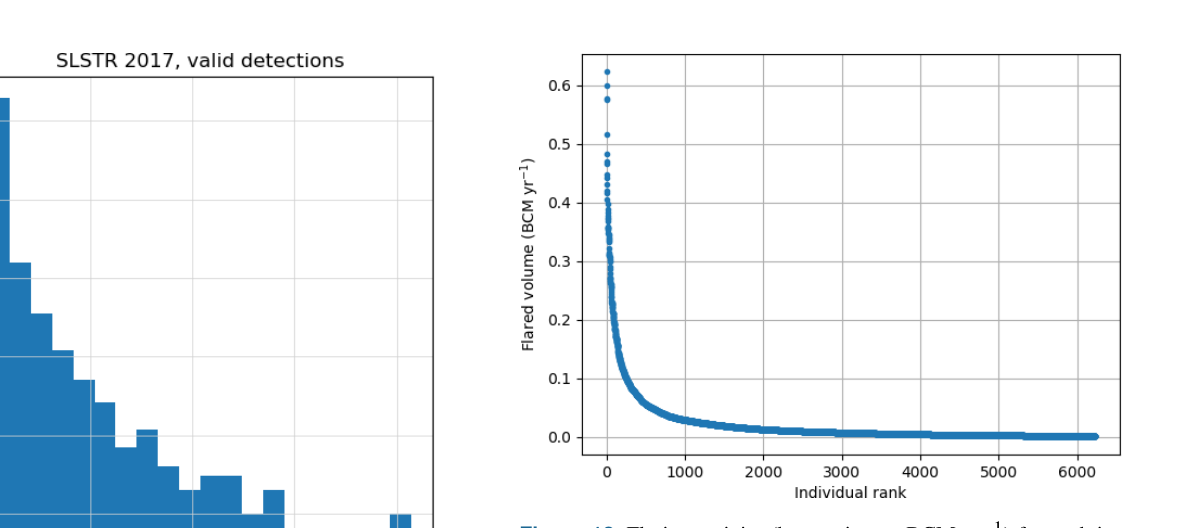
Figure 12. Flaring activity (best estimate, BCMyr − 1 ) for each in- dividual flaring location (6232 in